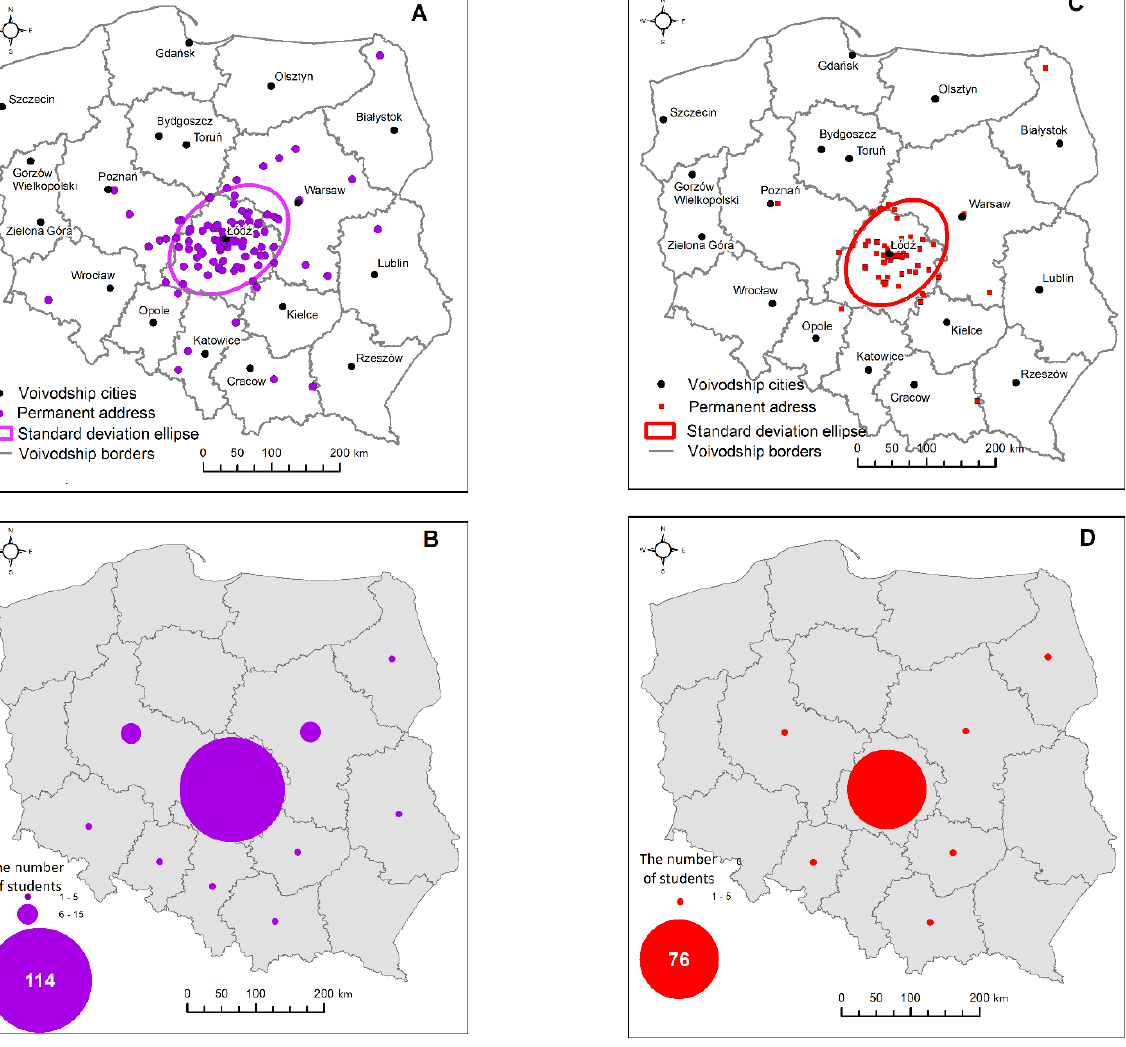
Figure 2. Residence of geoinformation students in the academic year 2016/2017 on the administrative division of Poland (( A , B ) data taken from the University of Lodz, ( C , D ) survey data). The place of residence of students obtained from surveys (approx. 55% of the popula- tion) was almost identical to that obtained from the university (Figure 2C,D), the sample showing a 10% surplus of the inhabitants of Ł ó d´z voivodeship, relative to the population as a whole. It was assumed that it was possible to make valid conclusions from the sample used. In a straight line, the furthest address point was located in Suwałki, almost 350 km north-east of the Faculty of Geographical Sciences, while the nearest was 0.2 km. Of the surveyed students, 38.6% temporarily changed their residence (Figure 3). The remaining 61.4% did not move during their studies, of which 28.4% lived in Ł ó d´z and 33% commuted to the university from outside of the